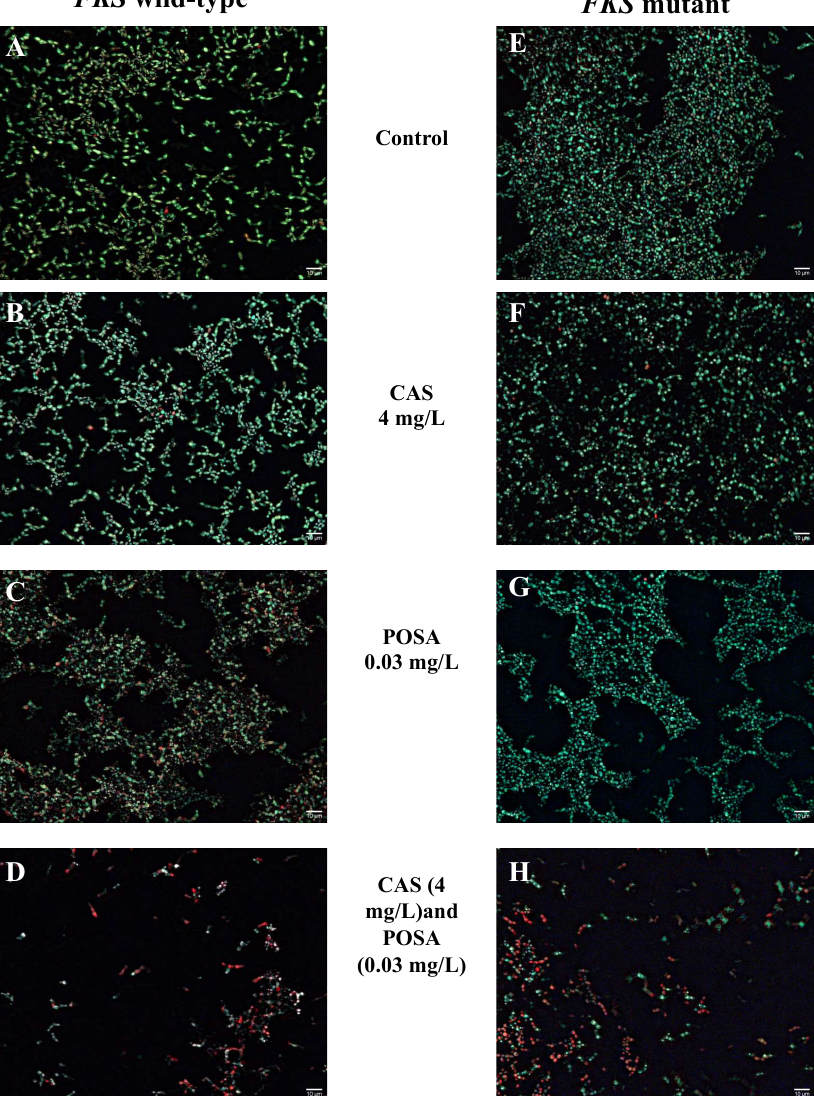
Figure 2. LIVE/DEAD fluorescence imaging of one Candida auris FKS wild-type (Ca_5) ( A – D ) and one FKS mutant (Ca_1) ( E – H ) representative isolates after caspofungin exposure with ( D , H ) and without ( B , F ) posaconazole. Pictures ( A , E ) show the untreated C. auris and biofilms, respectively, while picture ( C , G ) demonstrate the posaconazole-exposed biofilms for wild-type ( C ) and mutant ( G ), respectively. Live cells (green) and nonviable cells (red) were stained with Syto9 and propidium iodide, respectively. All images show typical fields of view. Scale bars represent 10 µ